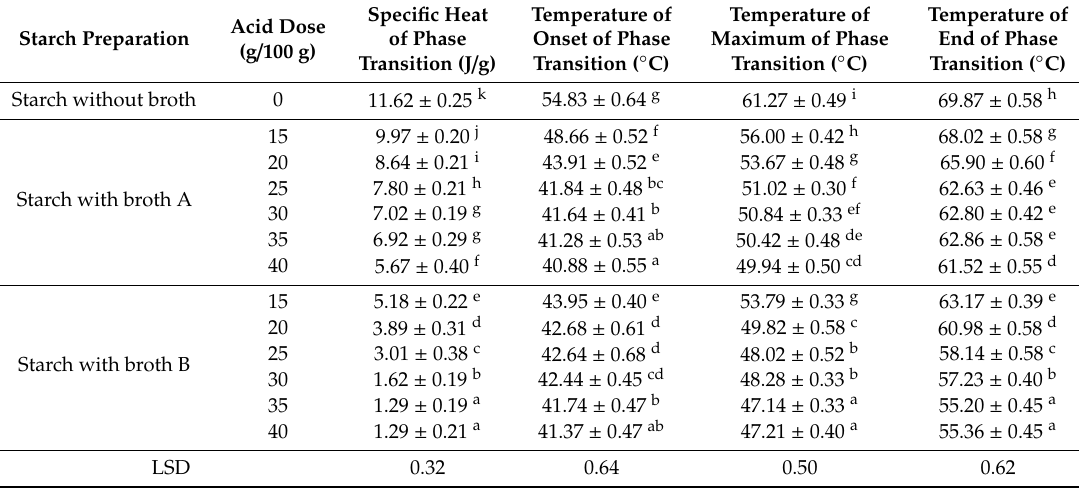
Table 1. Thermal analysis of starch esters as a ff ected by acid